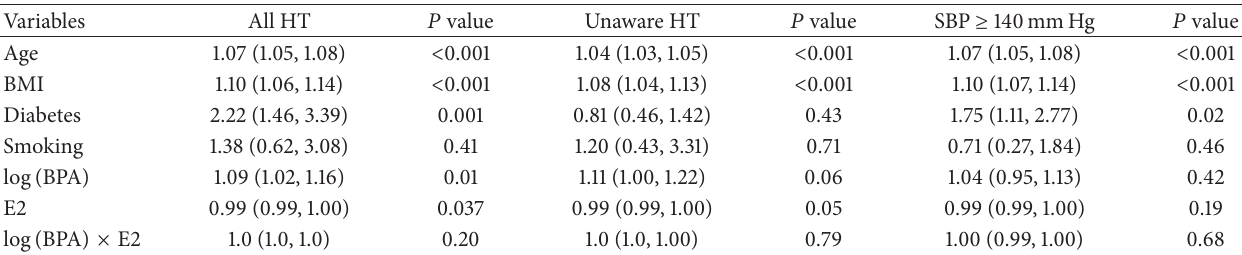
Table 4: Adjusted odds ratios for high blood pressure associated with log (BPA) and E2 level with interaction term of log (BPA) and E2 level among women.